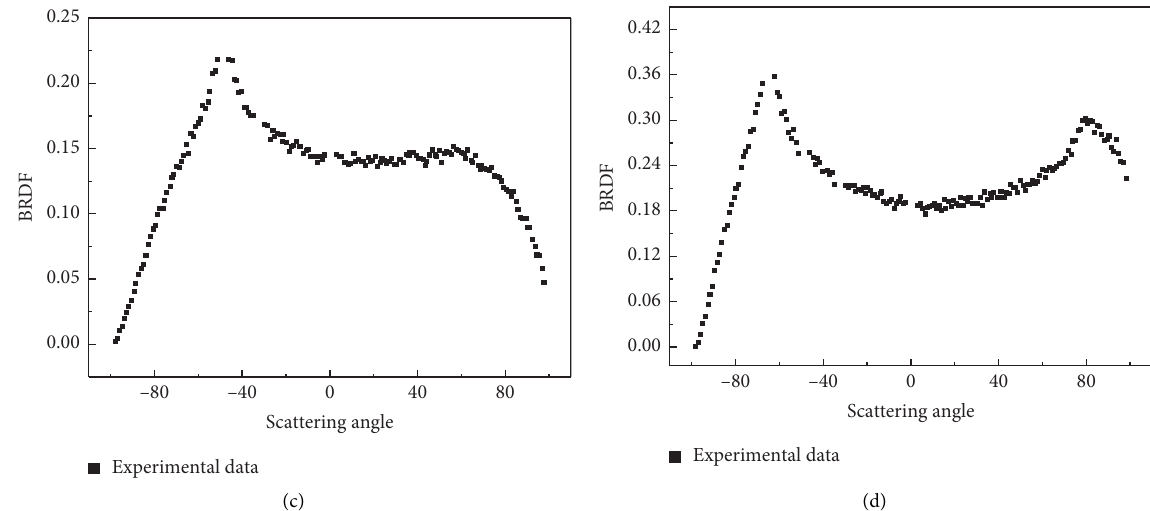
Figure 2: BRDF data of Martian soil. (a) Original data at 0 ° angle of incidence; (b) original data at 30 ° angle of incidence; (c) original data at 45 ° angle of incidence; (d) 3D data of 60 ° incident angle.